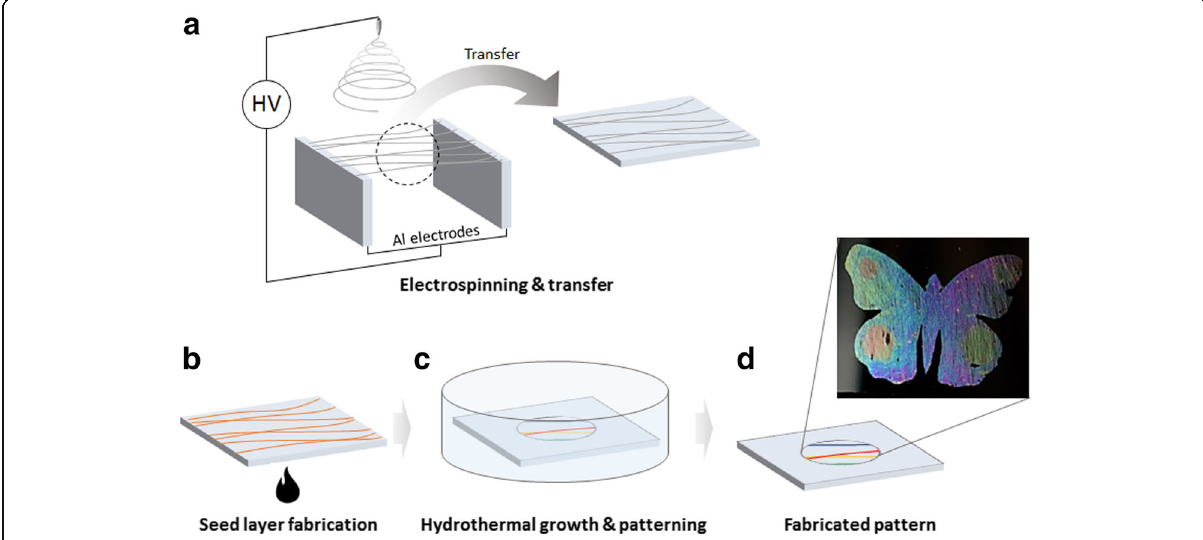
Fig. 1 Schematic illustration of the aligned zinc oxide (ZnO) structural color fabrication process. a The electrospun nanofiber is collected in a vertical direction between parallel electrodes and transferred to the target substrate. b To remove the polymer component of the transferred nanofiber, heat treatment is performed at 500 °C to form a seed layer. c Patterning is performed using masking tape, and hydrothermal growth is performed in a constant temperature bath. d Removing the masking tape completes the final pattern. (Additional masking and hydrothermal growth allow complex patterns to be